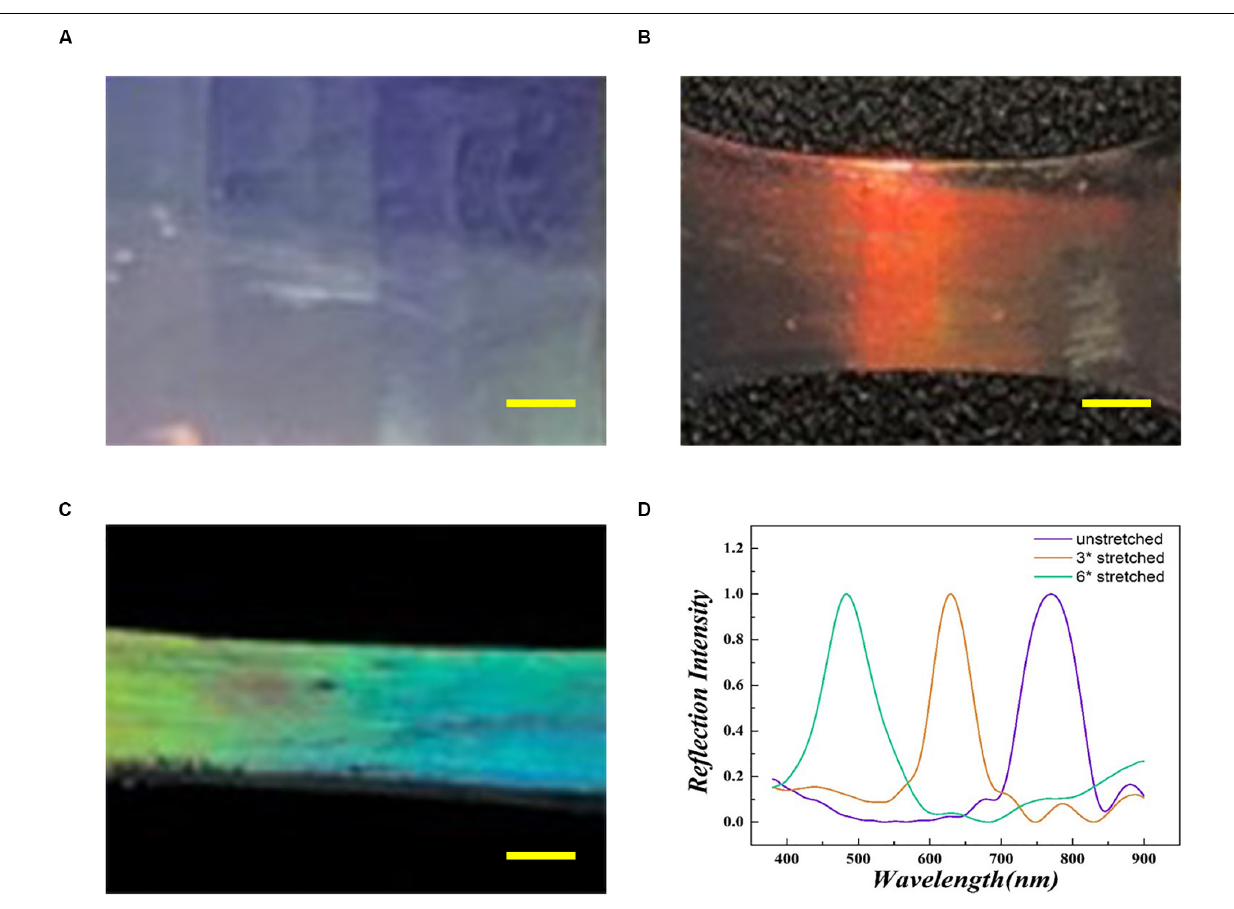
FIGURE 2 | Optical images of the inverse opal substrate (A) , the 3 × stretched substrate (B) , and the 6 × stretched substrate (C) . (D) The reflecting peaks of the inverse opal substrates. The purple line matches with panel (A) , the orange line matches with panel (B) , and the green line matches with panel (C) . Scale bars are 1 mm in panels (A–C)